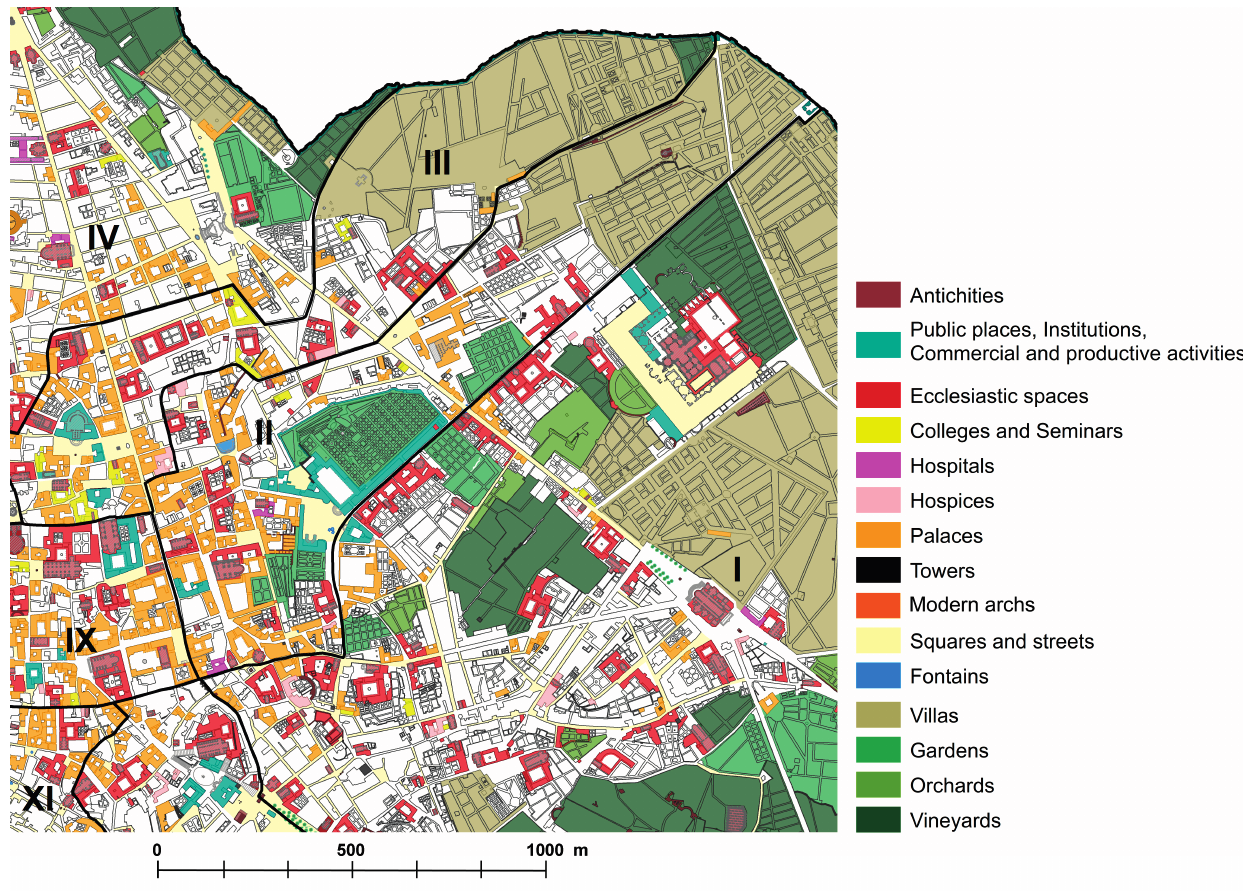
Figure 8. Urban functions in 1748, retrieved by the integrated index of the Nuova pianta ’s,